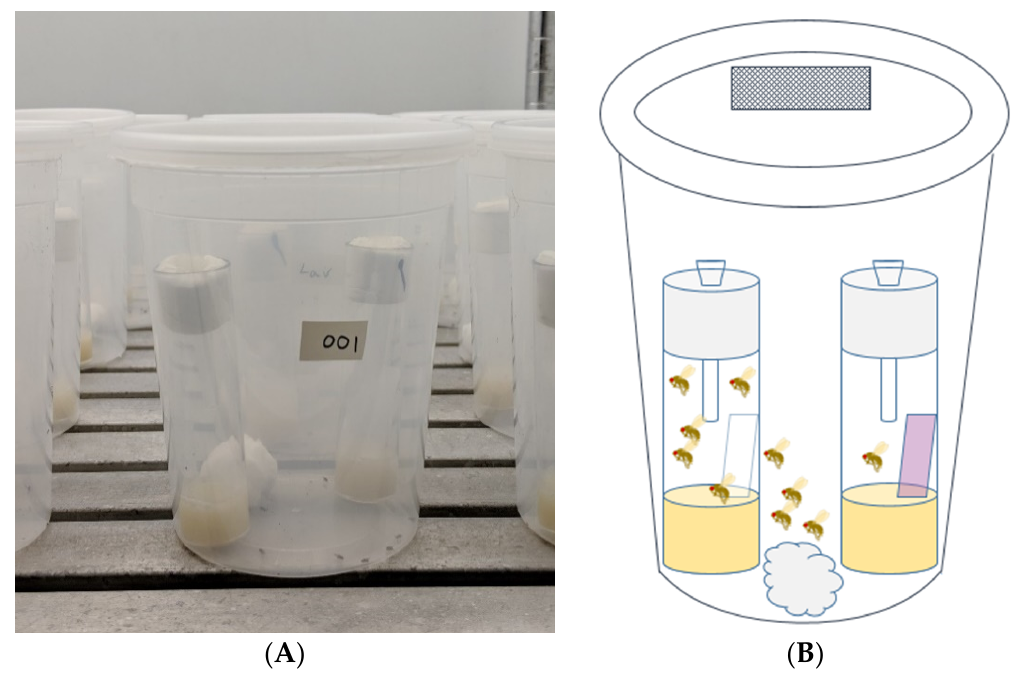
Figure 1. ( A ) Image of two-choice bioassay containers. ( B ) Schematic of two-choice bioassay arena constructed out of a 1 L clear plastic deli container and lid with a 1 × 2 cm section replaced with 80 g mesh netting, a moistened cotton ball, and two vials containing 5 mL of diet, a pipette-tip funnel through a foam stopper, and filter paper that was either treated with a botanical volatile organic compound or left untreated. Five male and five female Drosophila suzukii were placed in each container in a growth chamber for 24 h and afterwards, the number of flies in each vial was